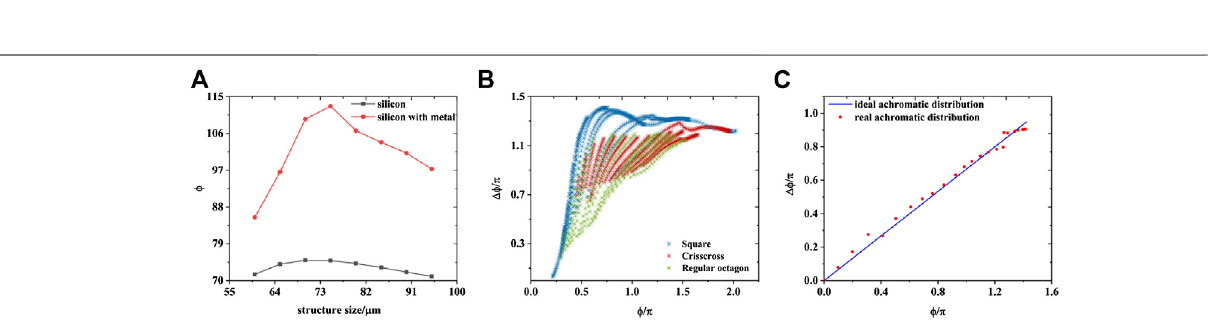
FIGURE 2 | (A) The phase-dispersion comparison of unit cells composed of different raw materials. (B,C) The amplitude and phase of the unit cells ’ transmission for different cross section shapes, respectively.